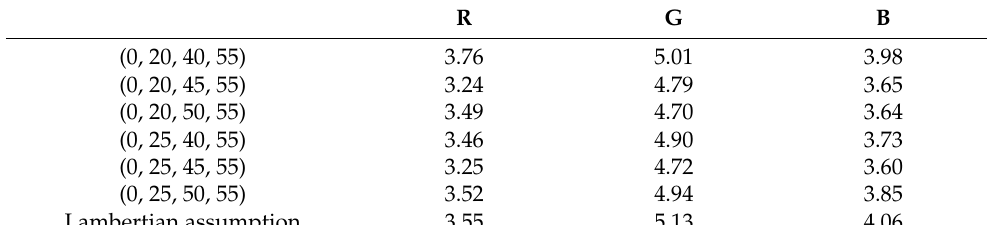
Table 4. Standard deviation of captured RGB values on the calibrated area (green projection onto open lens type).